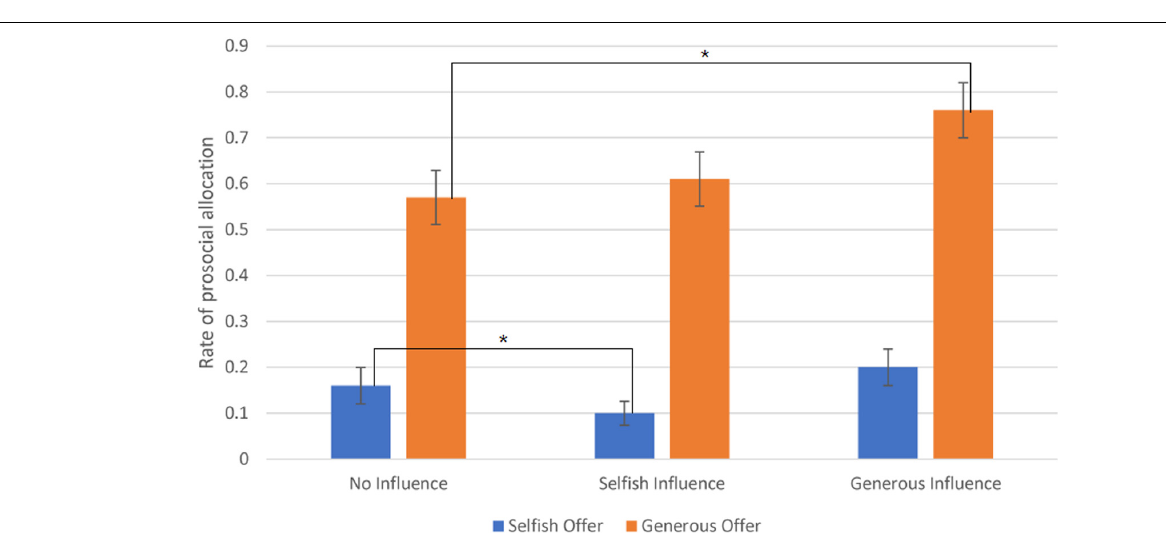
size = 3 mm × 3 mm × 3 mm. The first three images were discarded for the saturation